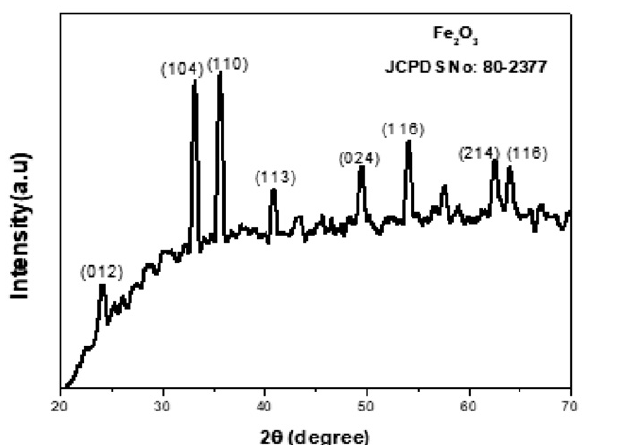
Figure 3. SEM images of Fe 2 O 3